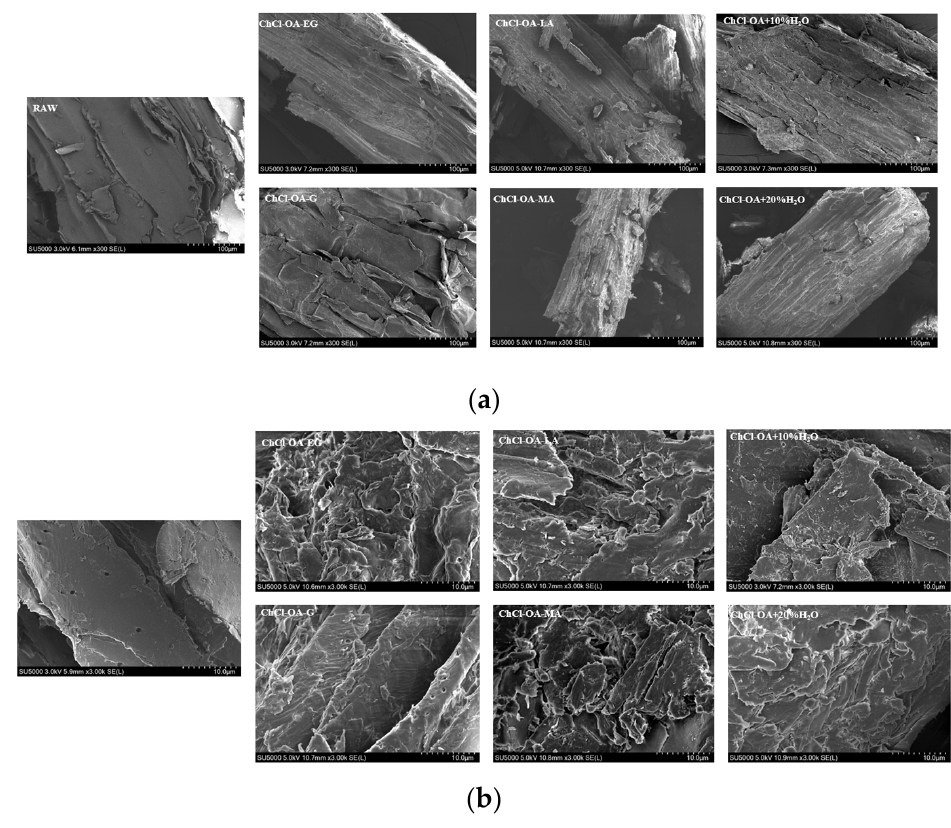
Figure 1. The Scanning electron microscope ( SEM) images of the original and pretreated bagasse at different magnifications: ( a ) 300×; ( b ) 3000×.